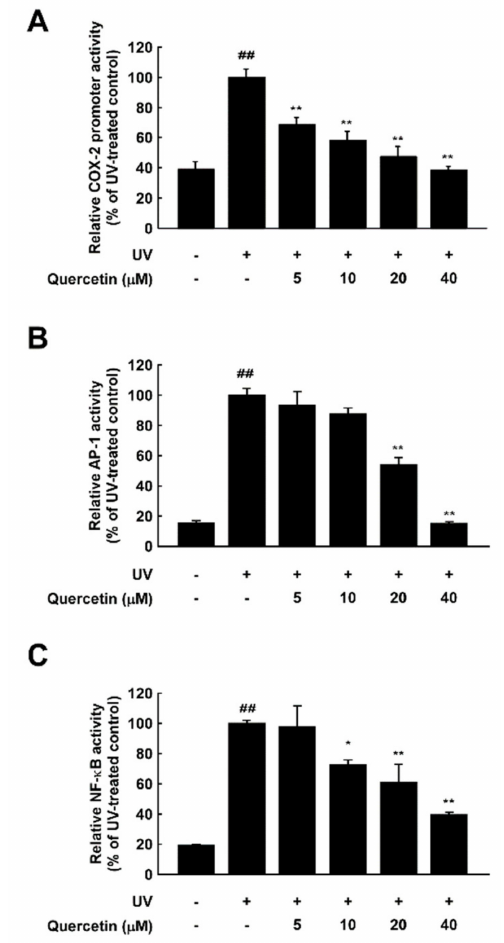
Figure 2. Inhibitory e ff ect of quercetin against UV-induced COX-2 promoter activity and AP-1 and NF- κ B activation. Cells stably expressing COX-2 promoter reporter or AP-1 or NF- κ B reporter plasmids were used. Quercetin was treated at the indicated concentrations for 1 h prior to UV irradiation. Luciferase activity was measured for ( A ) COX-2, ( B ) AP-1, and ( C ) NF- κ B. ## indicate significant ( p < 0.001) induction by UV compared to the un-treated control. *,** indicate significant ( p < 0.05, and p < 0.001, respectively) inhibition of activity by quercetin compared to the UV-only